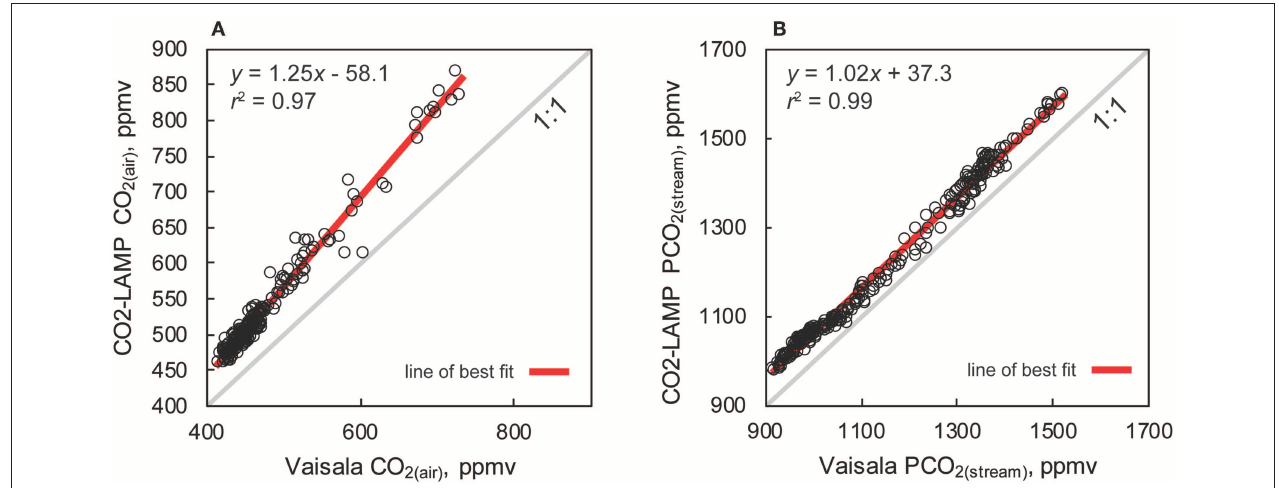
FIGURE 10 | CO2-LAMP vs. Vaisala measurements for (A) CO 2(air) and (B) Vaisala PCO 2(stream) .